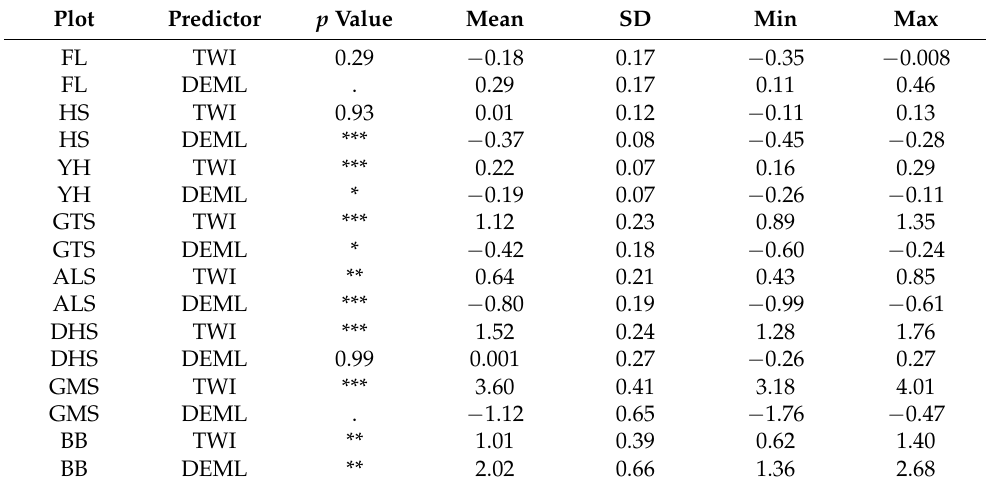
Table A2. Results for the fitted spatial simultaneous autoregressive error models (SARs).